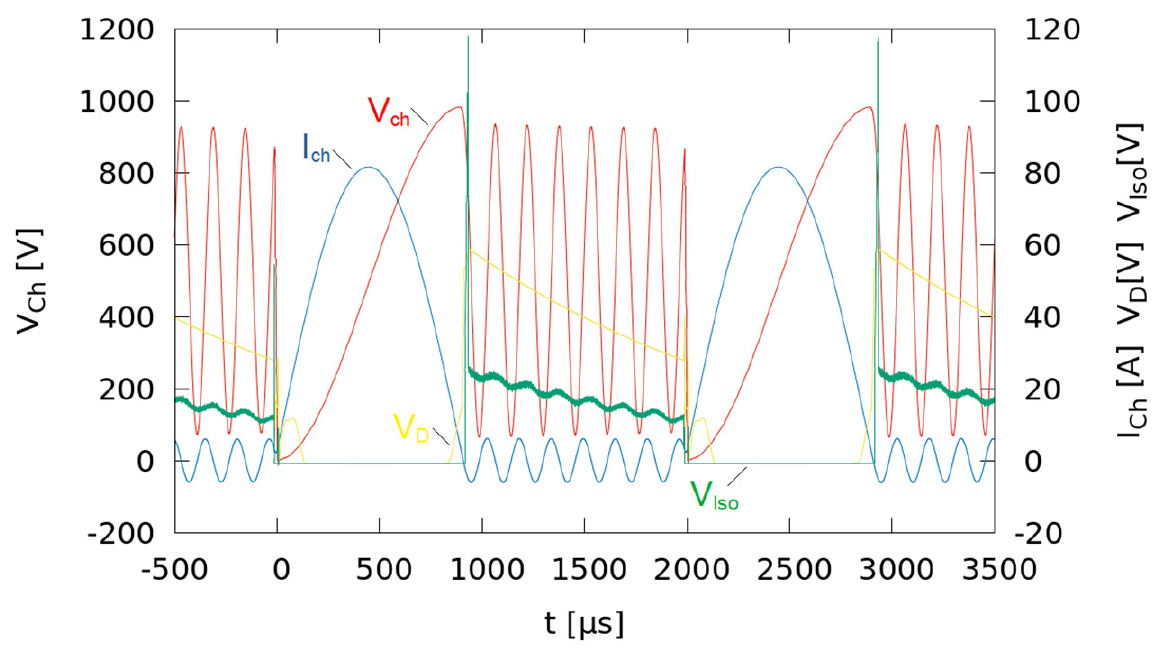
Figure 10. Simulated charging voltage V ch and the charging current I ch at the charging input terminal of the 8-stage Marx generator according to Figure 3, voltage V D across the damping resistor R D (i.e., R3 according to Figure 3), voltage V ISO of the ground-side terminal of the power supply versus ground (i.e., V L9,G according to Figure 4), on-time of the solid-state switches: 22 µs.